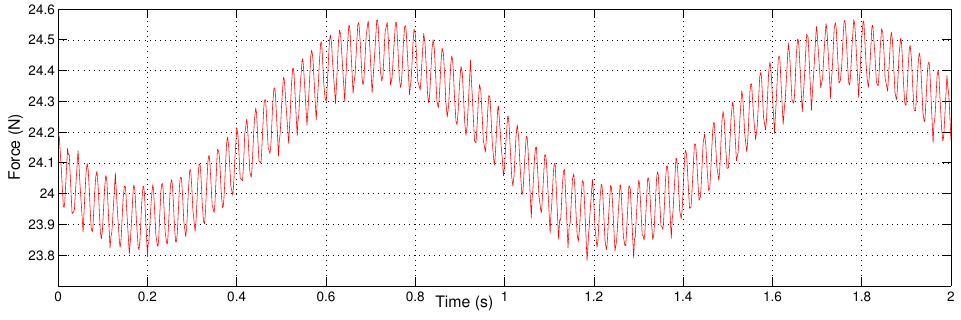
Figure 4. x -axis representation of cutting